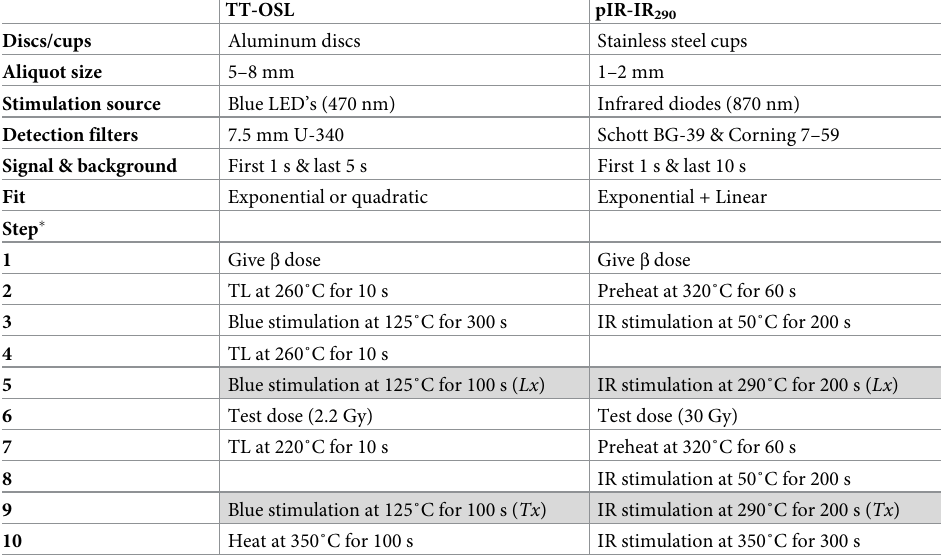
Table 1. Measurement protocols and details of quartz TT-OSL and feldspar pIRIR290 signals.